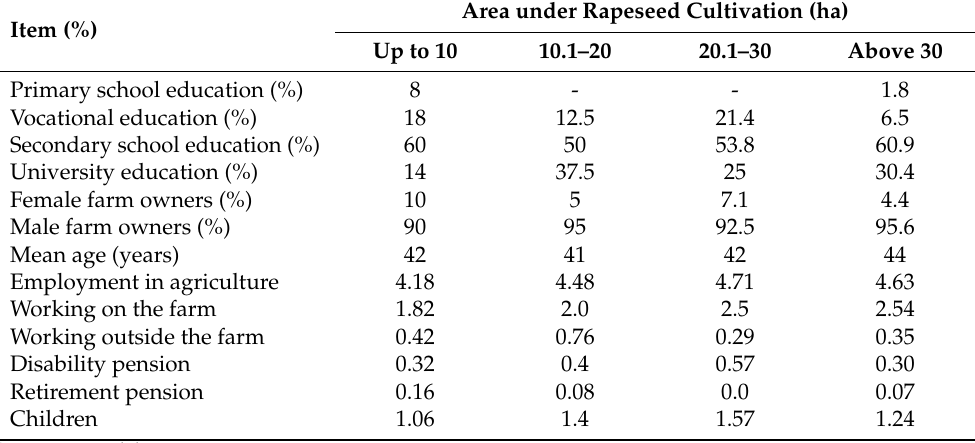
Table 8. Age, education and employment status of farmers in the analyzed farms with different area under rapeseed cultivation